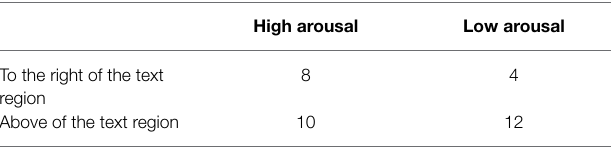
TABLE 3 | Summary table of found lateral and top (cells contain the number of participants).